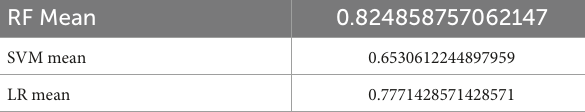
TABLE 4 Random forest model quality after optimization.